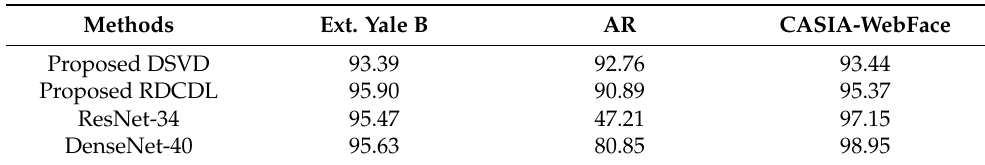
Table 6. Average accuracy (%) of various methods on the AR, Yale B database and CASIA- WebFace